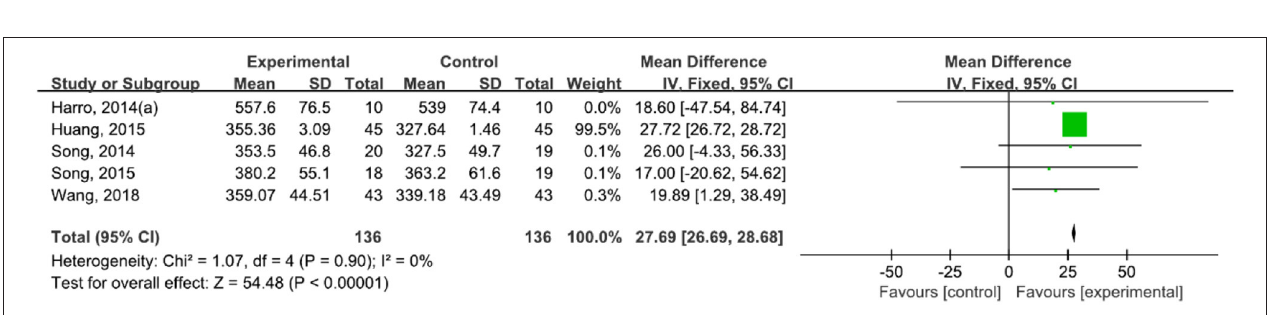
FIGURE 8 | Forest plot showing MD (with 95% CI) for 6MWT of the included studies comparing the experimental and control